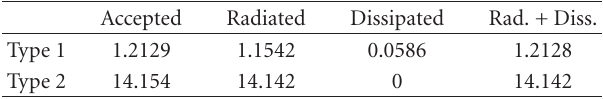
Table 1: For two types of arrays, with 8 elements each, power delivered to the array at port 1, radiated power, power disspiated in loads of other elements and sum of radiated and dissipated powers. Units are